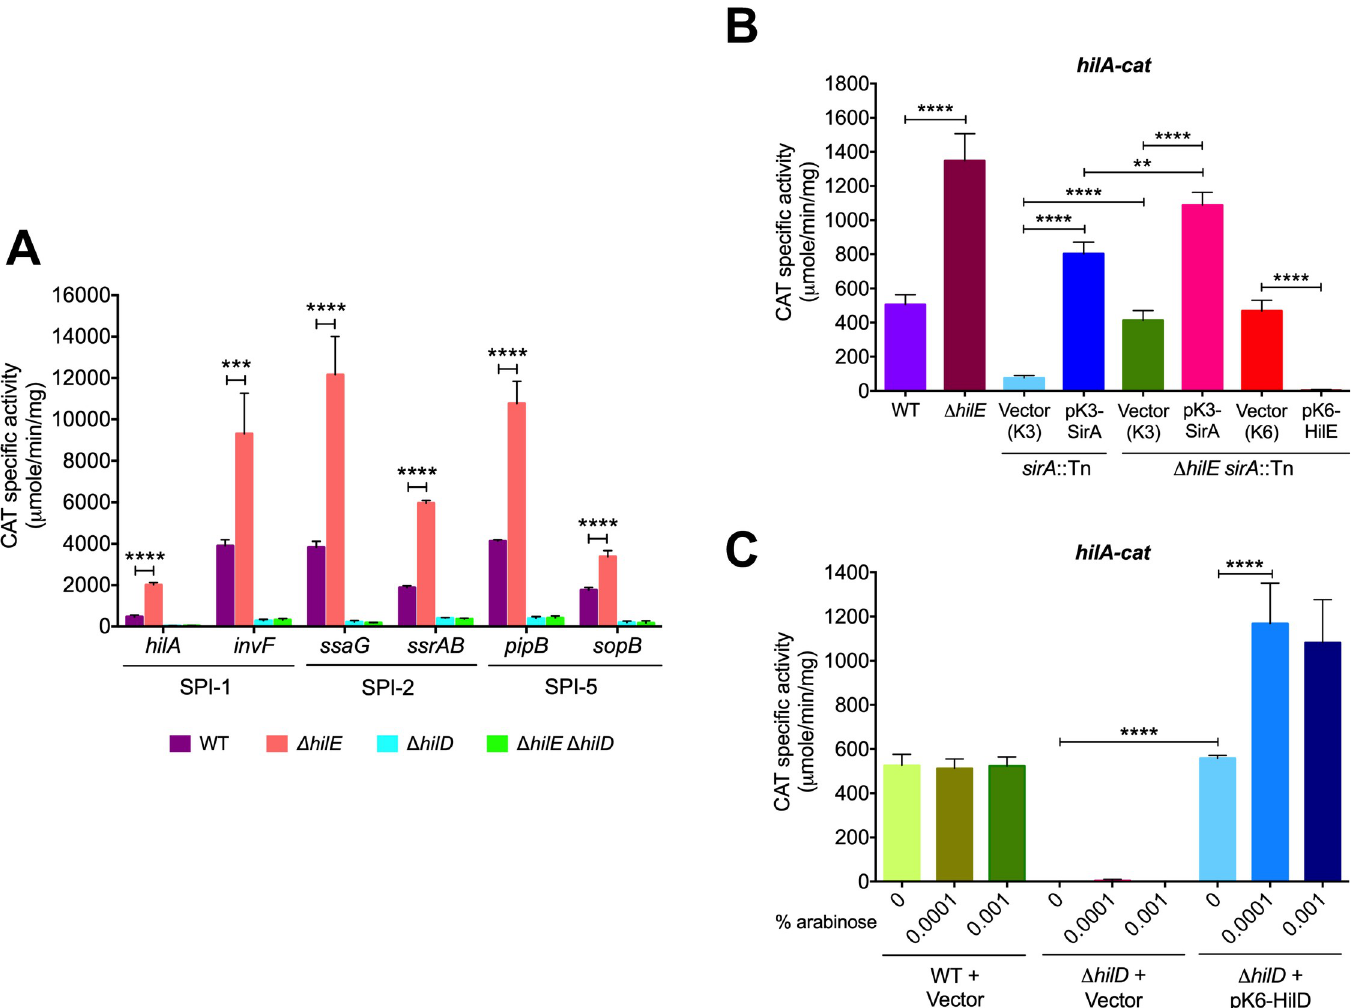
Fig 4. HilE represses the expression of genes regulated by HilD. (A) CAT activity of the hilA-cat , invF-cat , ssaG-cat , ssrAB-cat , pipB-cat and sopB-cat transcriptional fusions, contained in plasmids philA-cat, pinvF-cat, pssaG-cat, pssrAB-cat, ppipB-cat and psopB-cat, respectively, was determined in the WT S . Typhimurium strain and its derivative Δ hilE , Δ hilD and Δ hilE Δ hilD mutants. (B) CAT activity of the hilA-cat transcriptional fusion, contained in the philA-cat plasmid, was determined in the WT S . Typhimurium strain and its derivative Δ hilE , sirA ::Tn 10 d and Δ hilE sirA ::Tn 10 d mutants in the absence or presence of pMPM-K3 or pMPM-K6 vectors, the pK3-SirA plasmid expressing SirA from a constitutive promoter or the pK6-HilE plasmid expressing HilE from an arabinose-inducible promoter. Expression of HilE from pK6-HilE was induced by adding 0.001% L-arabinose to the medium. (C) CAT activity of the hilA-cat transcriptional fusion, contained in the philA-cat plasmid, was determined in the WT S . Typhimurium strain and its derivative Δ hilD mutant carrying the pMPM-K6 vector or the pK6-HilD plasmid, which expresses HilD from an arabinose- inducible promoter. Expression of HilD from pK6-HilD was induced with 0%, 0.0001% or 0.001% L-arabinose. CAT-specific activity was obtained from samples collected from bacterial cultures grown in LB at 37˚C. Data represent the average of three independent experiments done in duplicate. Error bars indicate the standard deviations. Statistically different values are indicated ( �� , p -value < 0.01; ��� , p -value < 0.001; ���� , p -value < 0.0001).